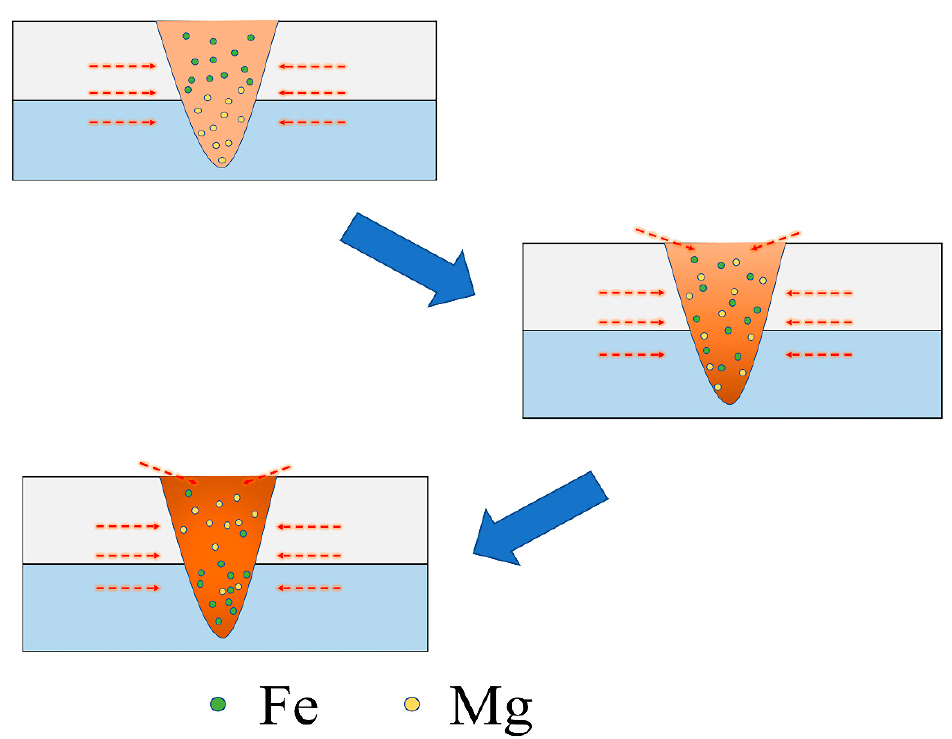
Figure 6. Flow chart of the prime diffusion.